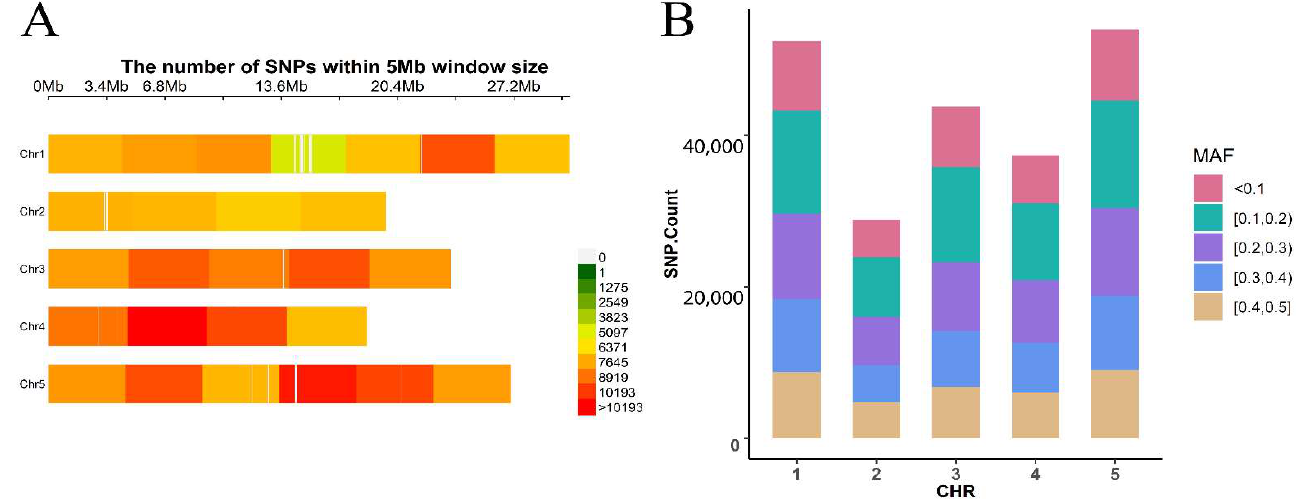
Figure 1. Marker density ( A ) of Arabidopsis natural population showing with color lumps with 1 Mb window size. MAF ( B ) of Arabidopsis natural population whole genomic SNPs for 5